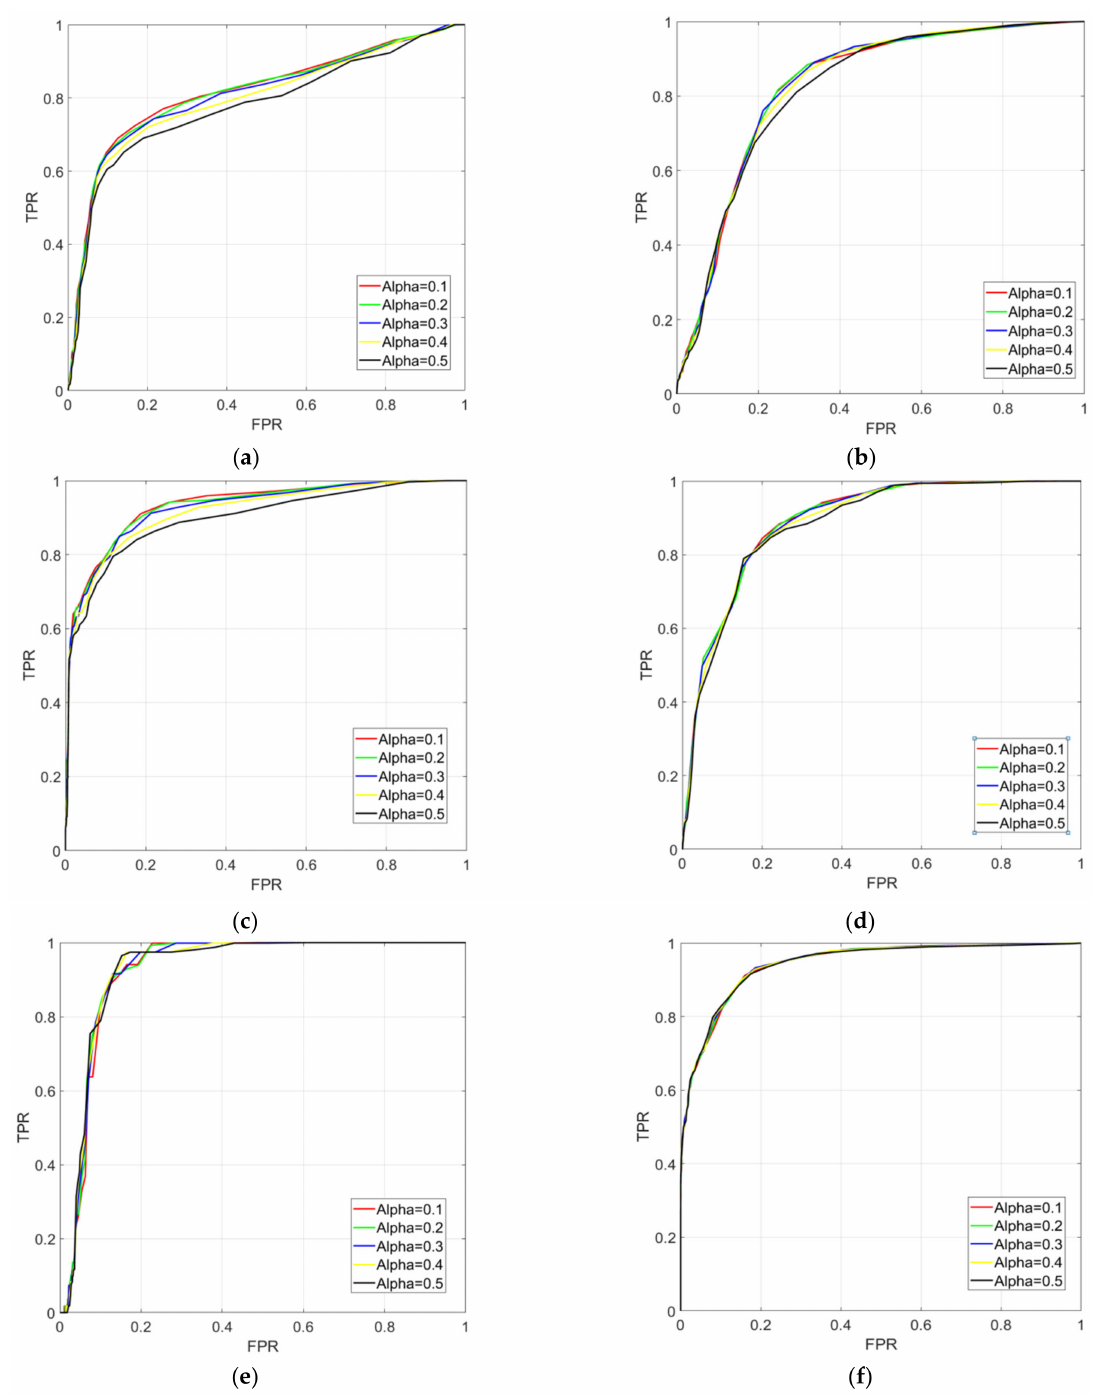
Figure 21. ROC curves of different α on six image pairs: ( a ) Image pair-1; ( b ) Image pair-2; ( c ) Image pair-3; ( d ) Image pair-4; ( e ) Image pair-5; ( f ) Image